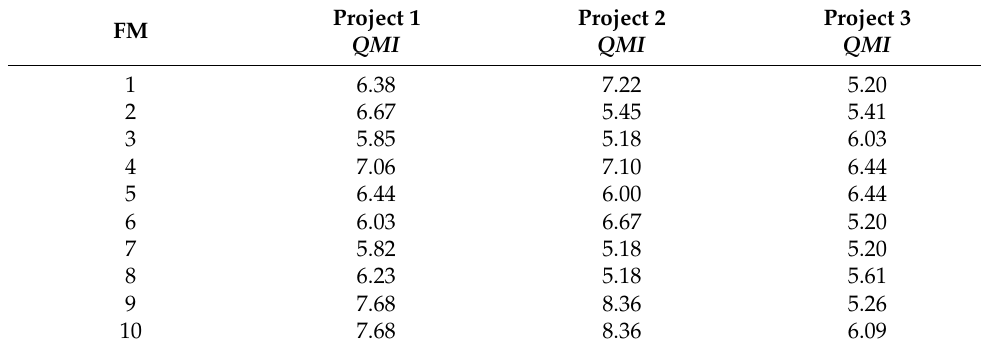
Table 8. QMI results for the three design projects considered in this study.